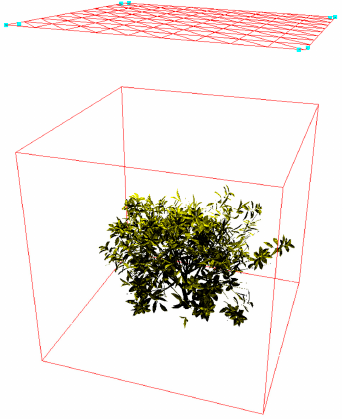
Figure 4. Schematic diagram for defining the reference projection plane of direct solar light. The eight cyan points on the plane indicate the projection of the octree bounding box onto the plane, and they define the size of the plane.